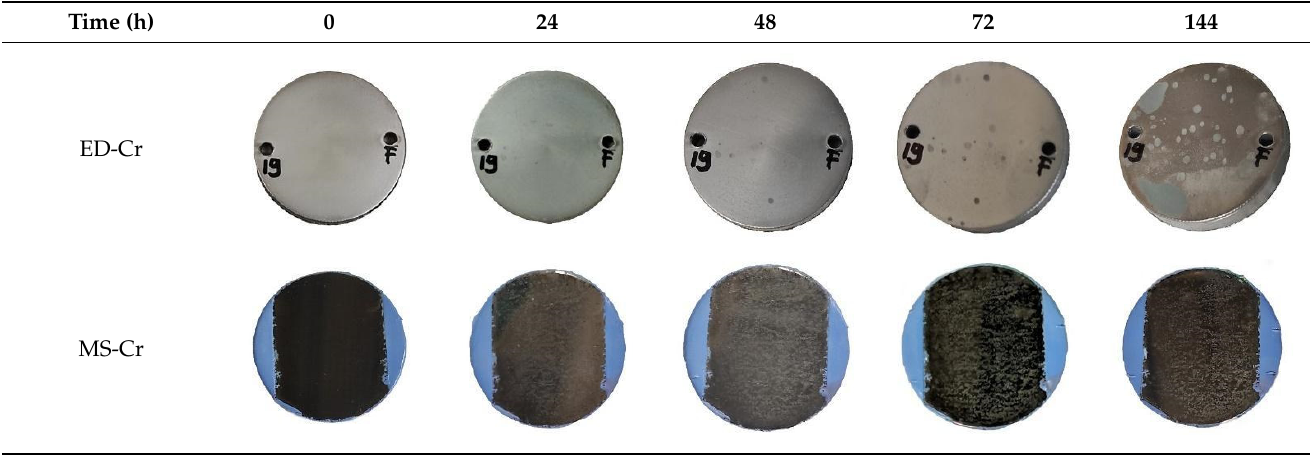
Table 3. Images of the samples exposed to saline environment as function of time. An ED-Cr sample (above) and a MS-Cr ones (below).